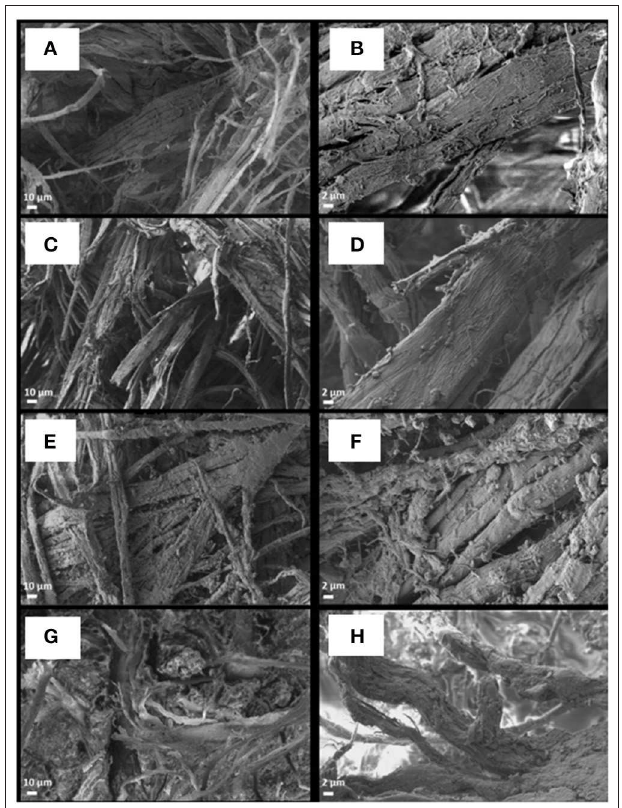
FIGURE 3 | Surface evaluation of the leather damage. SEM micrographs of the non-irradiated sample [ (A) and its magnification (B) ], of the leather irradiated with a dose of 750Gy (C,D) , with a dose of 1,000Gy (E,F) and with the maximum dose of 5,000Gy (G,H) . Non-significant differences can be observed in the surface morphology of the sample irradiated with doses up to 1,000Gy with respect to the non-irradiated one. A huge variation is instead visible in the fibers preservation condition of the sample irradiated with 5,000Gy, where the surface shows wide areas of gelatinized materials [particularly visible in (G) ] and the fibers bundles appear reduced in their dimension, frayed and fragmented (H) .